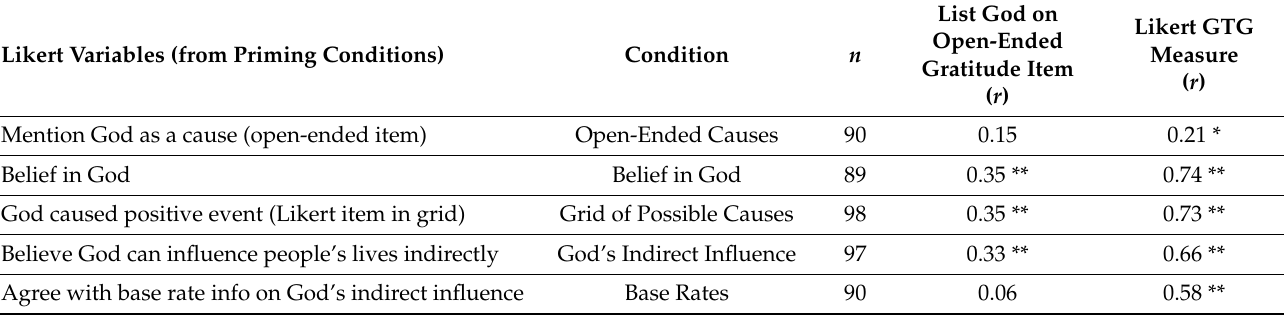
Table 4. Correlations between Within-Condition Responses and Ratings of Gratitude to God.